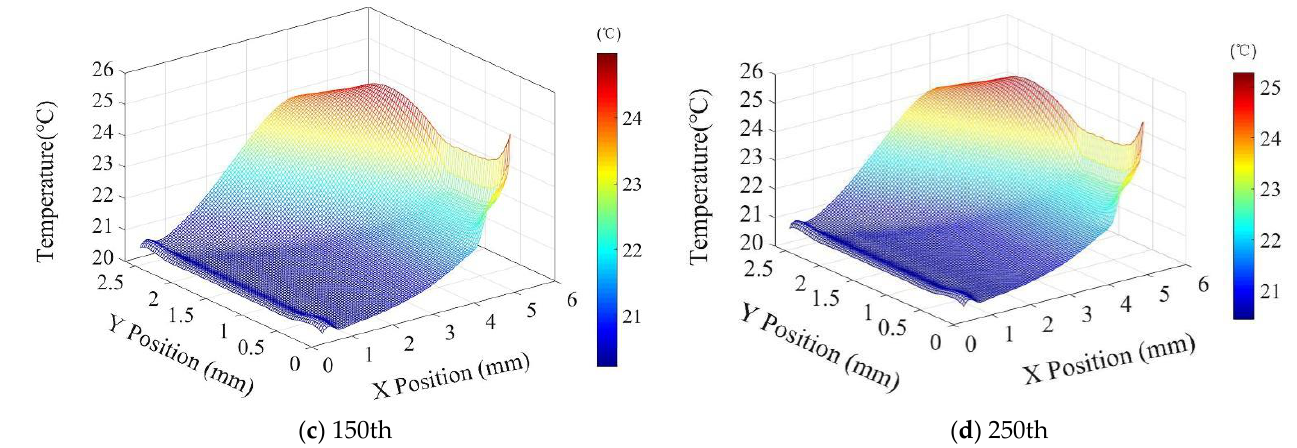
Figure 18. 3D temperature distribution of the X–Y direction section of the tool nose region.